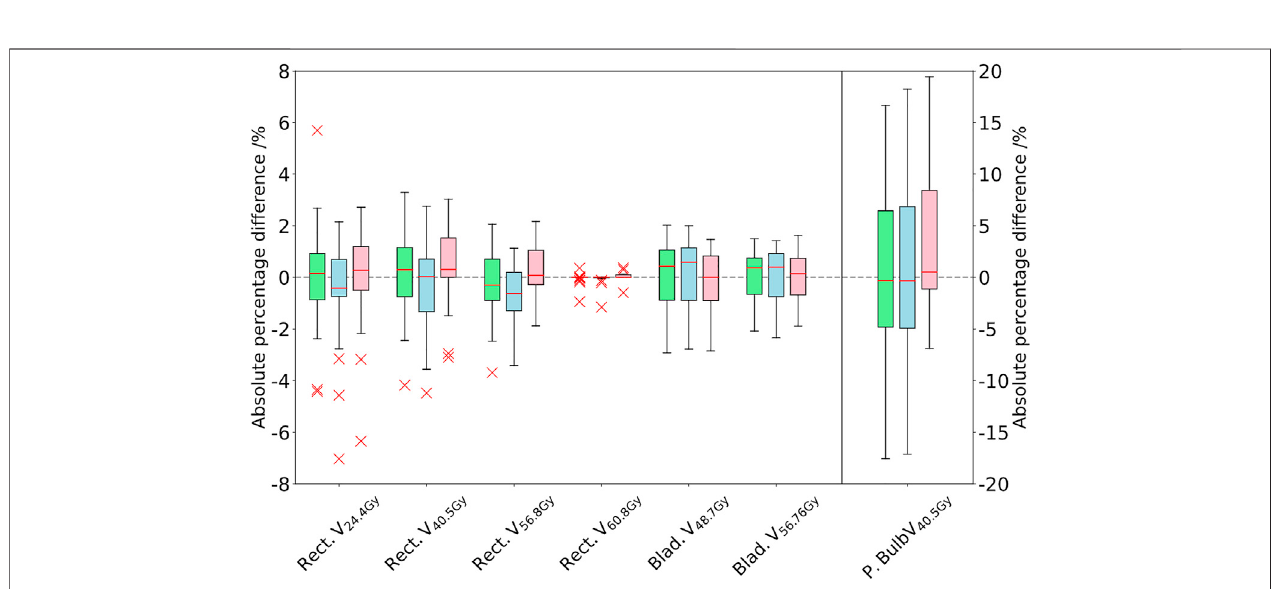
FIGURE 2 | Comparison of absolute dose differences toward the GS CT plan for the three investigated approaches PSCT (green), PBCT (blue), and AICT (pink). DVH parameter differences are given by subtraction of the GS from the work fl ow method.